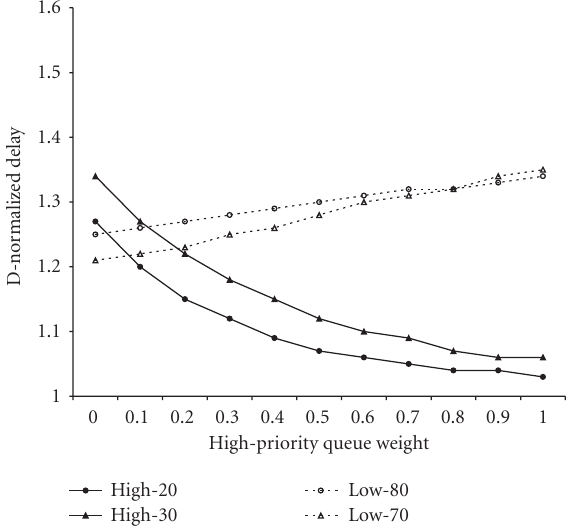
Figure 8: Universal performance factor for di ff erent priority classes under varying high-priority queue weights and full load.